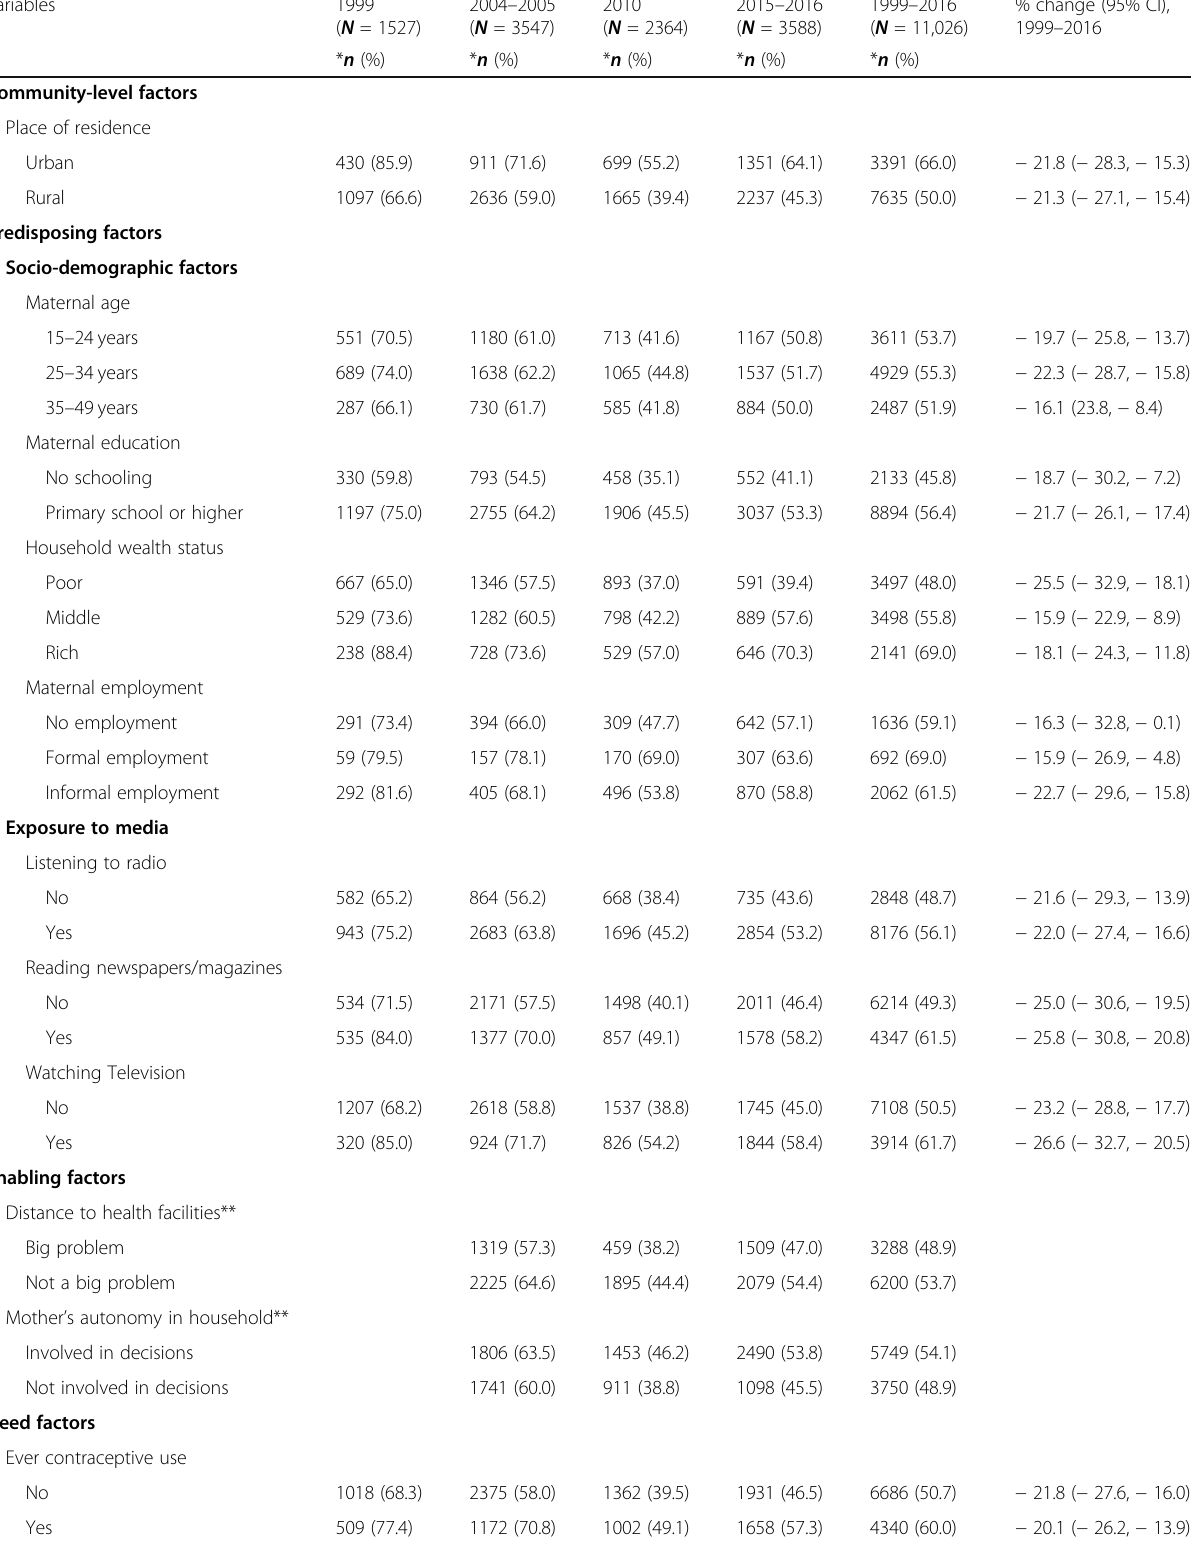
Table 3 Prevalence of four or more antenatal care visits by the study factors in Tanzania, 1999 –